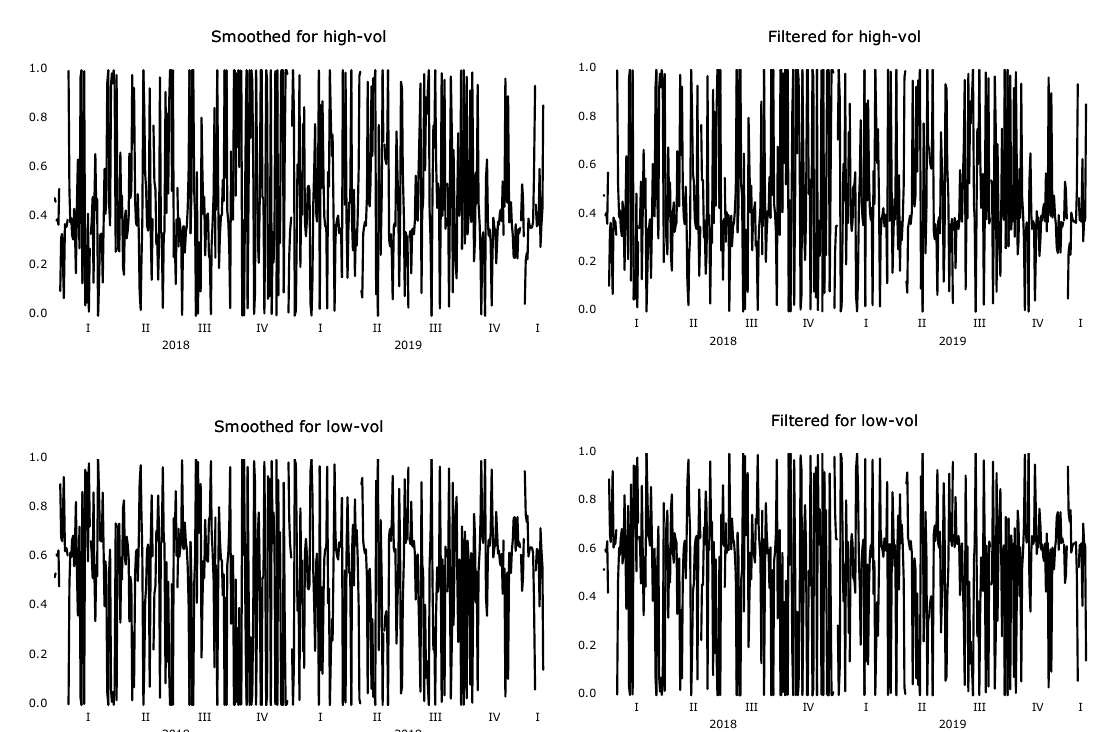
Figure 6. Computed smoothed probabilities and filtered conditional volatilities for HACK.